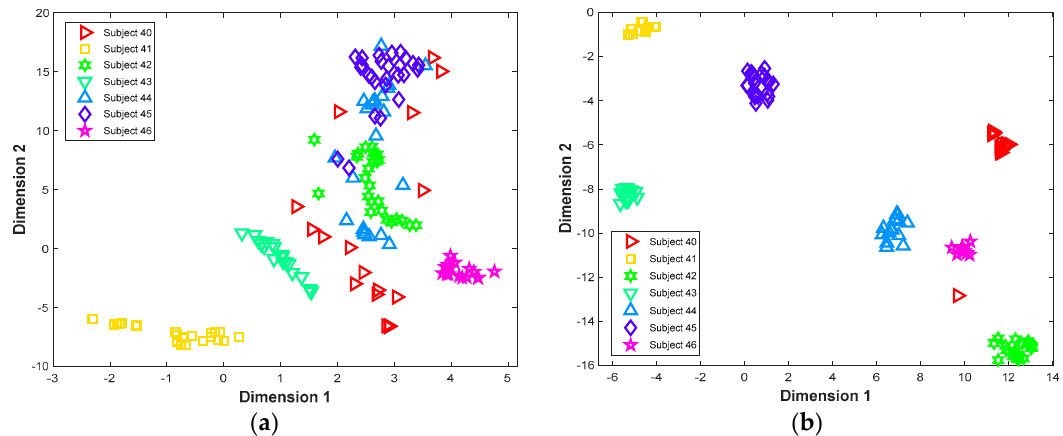
Figure 14. Features visualization by t-SNE. ( a ) Original temporal-frequency features; ( b ) Learned features by S-AEs.